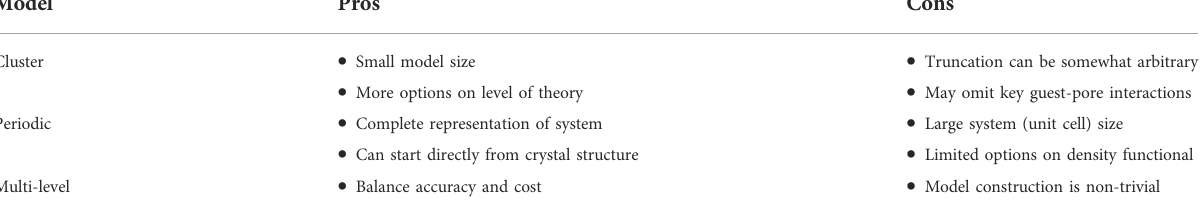
TABLE 1 Comparison of cluster, periodic and multi-level models in computational catalysis. Model Pros